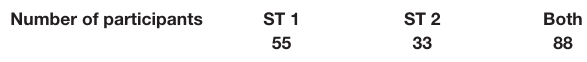
TABLE 2 | Circadian parameters